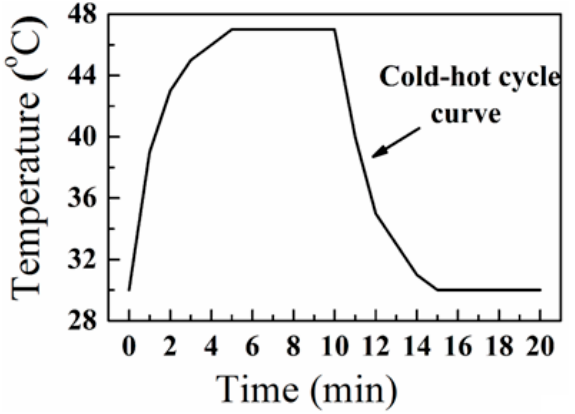
Figure 3. The temperature curve of a single cold–hot cycle excitation.